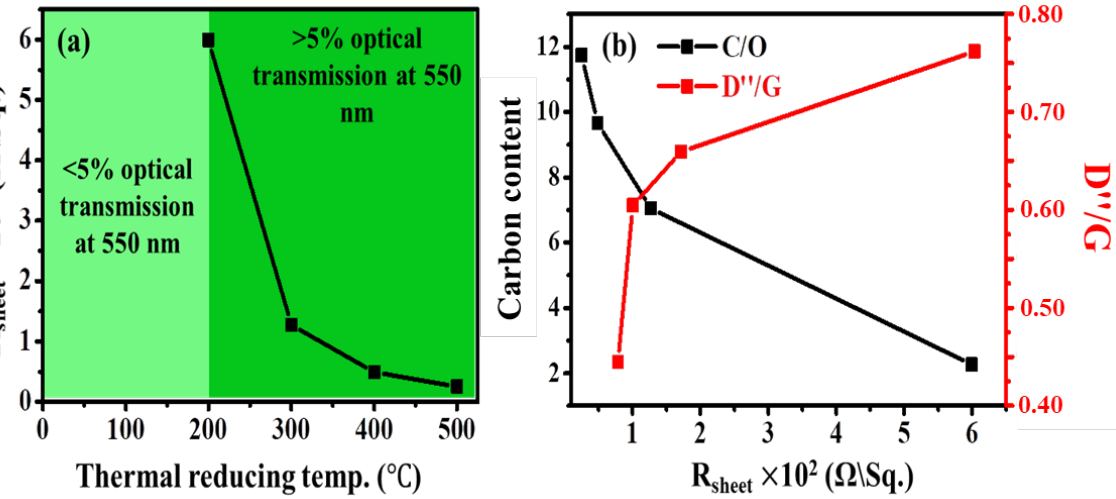
Figure 7. ( a ) Sheet resistance as a function of RT of the TRGO-200 to TRGO-500 and ( b ) carbon content and D′′/G as function of sheet resistance.